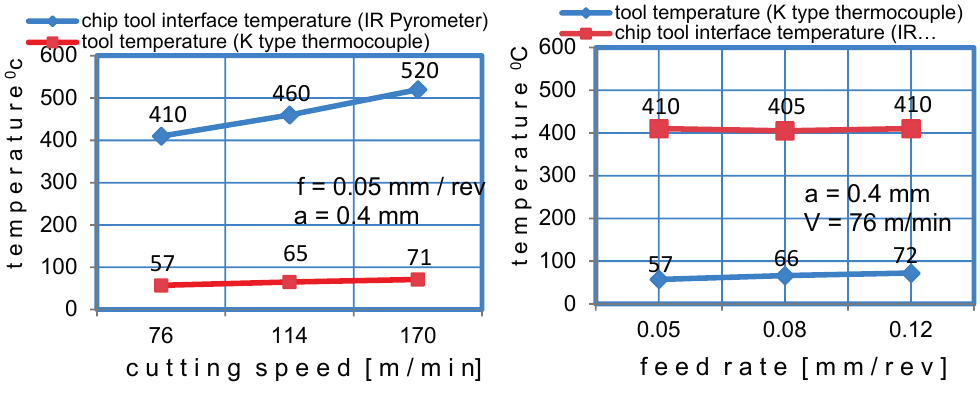
Figure 11. The influence of cutting speed and feed rate on